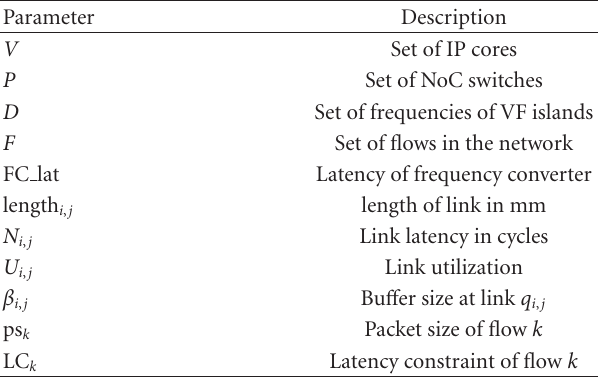
Table 1: Network